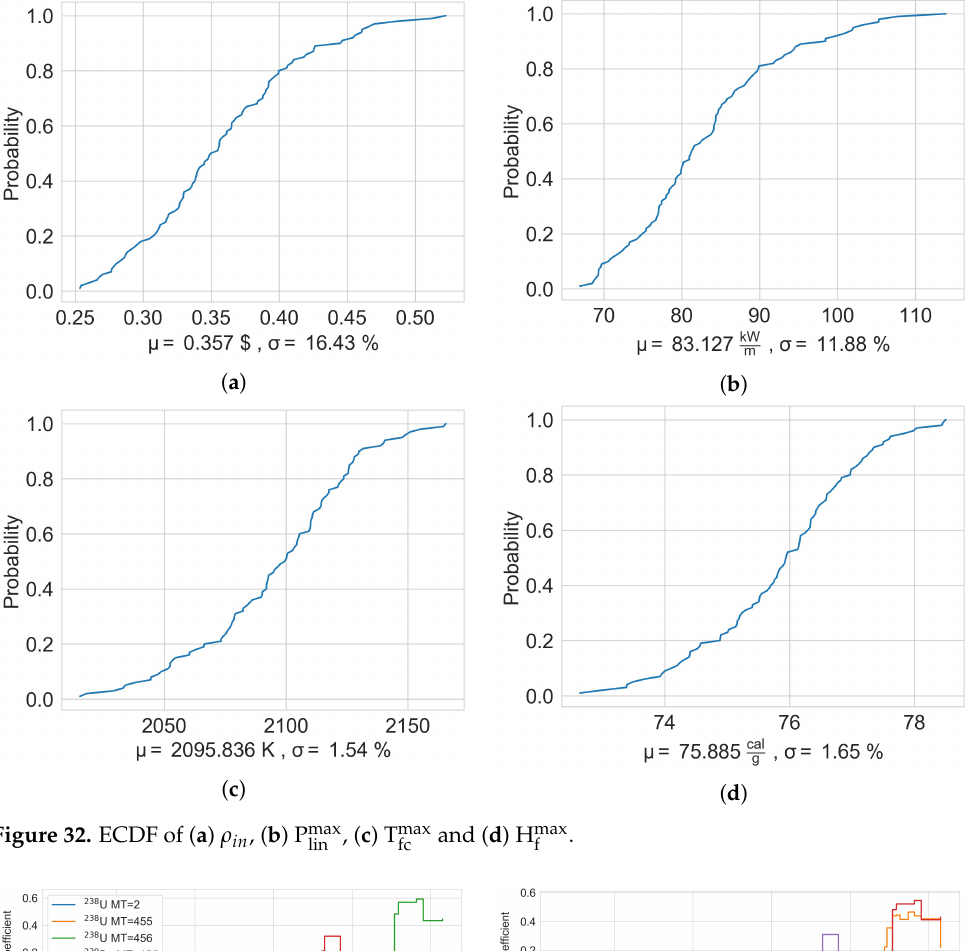
, ( c ) T max and ( d ) H max lin fc